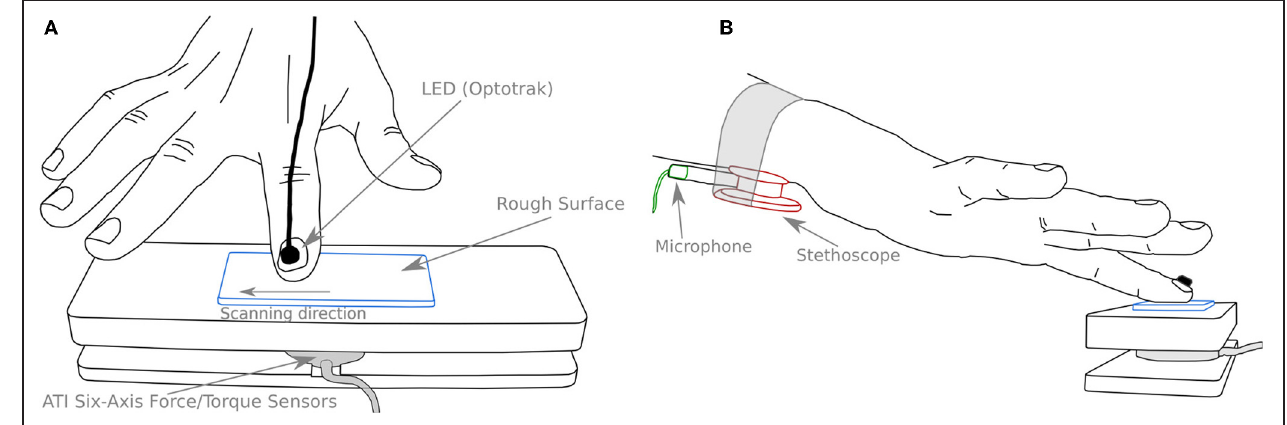
FIGURE 2 | Schematic view of the experimental setup. (A) The stimulus (blue) is fixed on the upper part of the apparatus. A force/torque sensor (gray) measures normal and tangential forces. A LED (thick black) is glued to the subject’s finger to measure its position. (B) A stethoscope (red) is